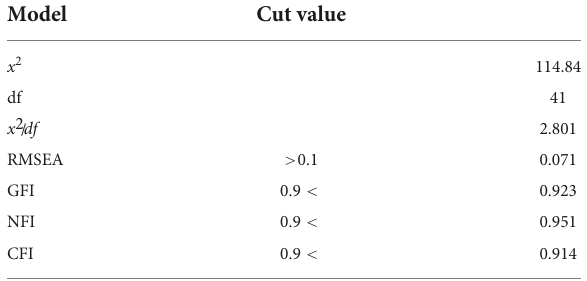
TABLE 3 Fit indices (model